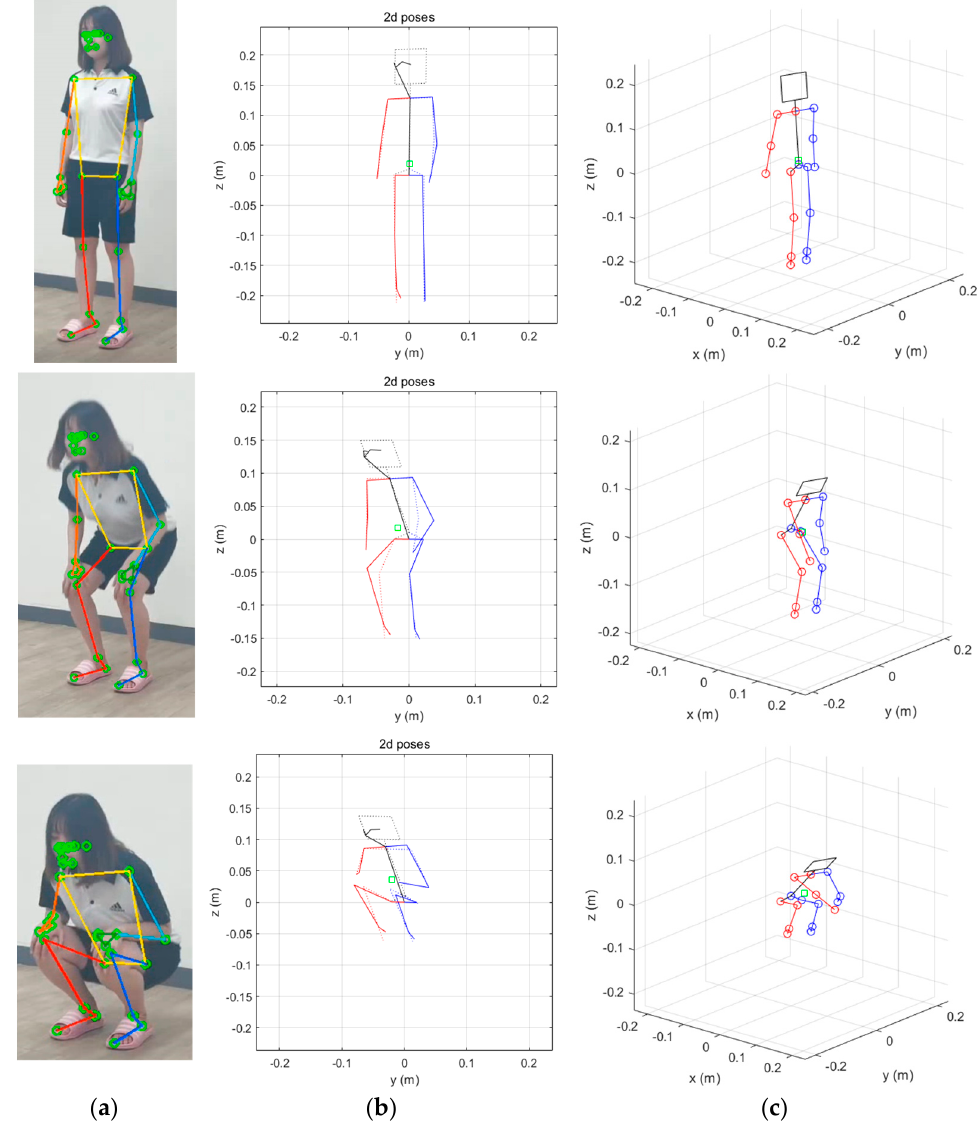
Figure 11. Pose estimation results for three poses generated by the humanoid model. ( a ) Original images and MPP results overlaid, ( b ) comparison between the MPP model (solid line) and the fitted humanoid model (dotted line) in 2D plane, and ( c ) the humanoid model reconstructed in 3D plane (red line: right parts, blue line: left parts).